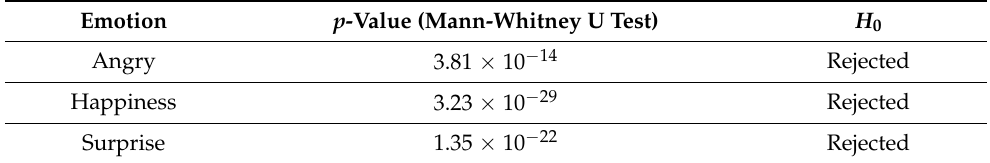
Table 5. Mann–Whitney U tests to compare the scores obtained from the classifier per emotion.